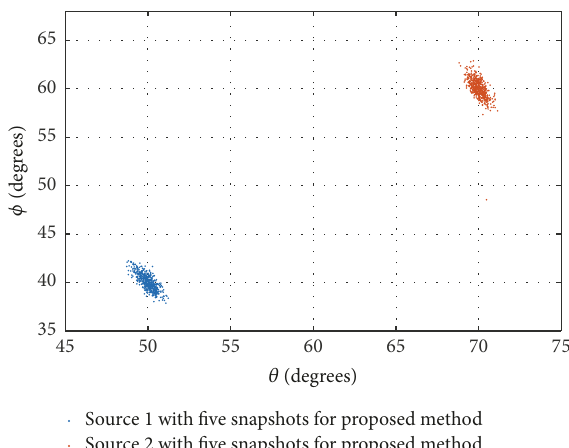
Source 1 with five snapshots for proposed method Source 2 with five snapshots for proposed Figure 13: Scatter plot for the proposed method in the presence of two coherent sources located at (𝜃 1 = 40 ∘ ,𝜙 1 = 50 ∘ ) and (𝜃 2 = 60 ∘ ,𝜙 = 70 ∘ ) with SNR = 0dB and five 2